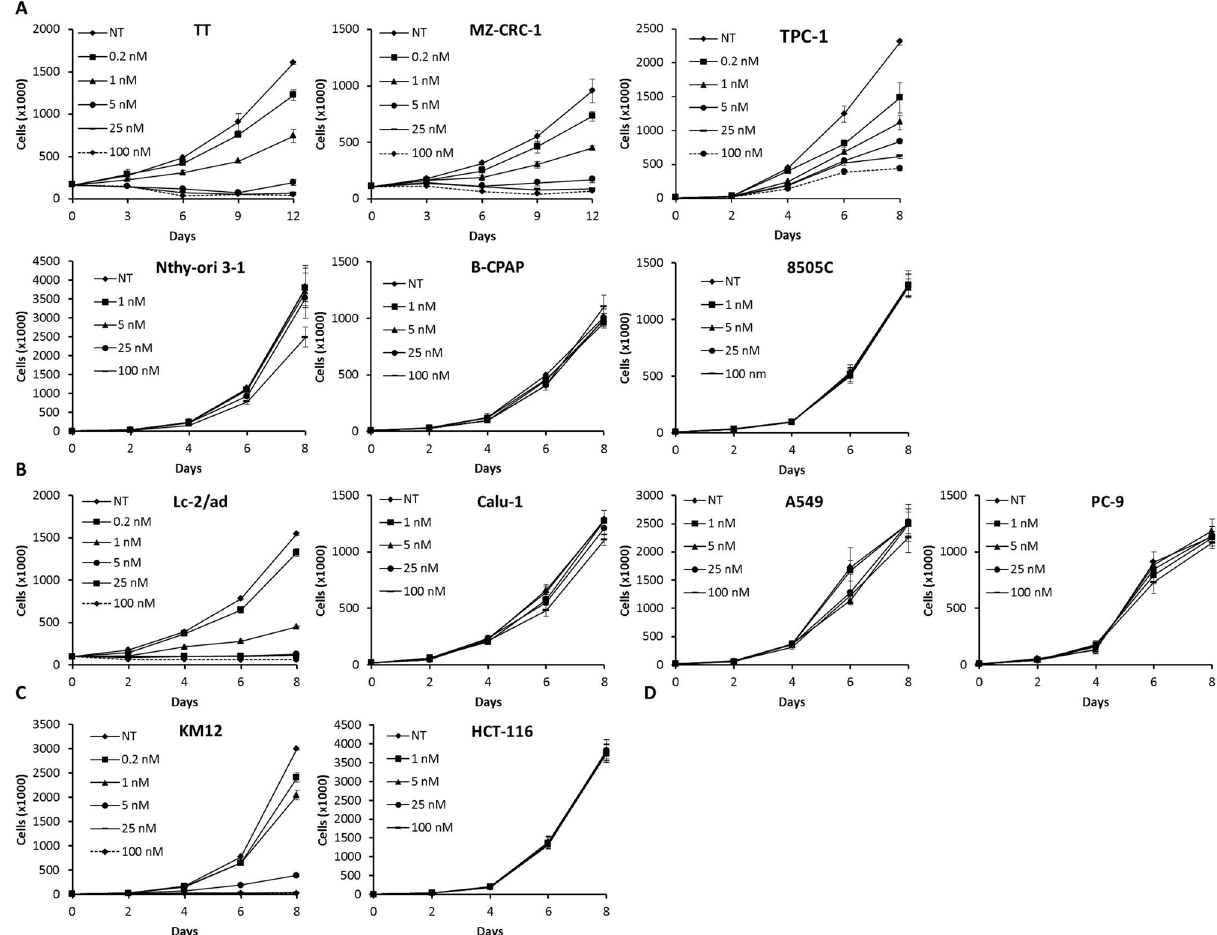
Figure 3. The indicated cell lines were incubated with vehicle (NT: not treated) or increasing concentrations of Pz-1 and counted at the indicated time points. Data are the mean ± SD of a single experiment performed in triplicate. Number of cells plated at Day 0: TT (200,000/well); MZ-CRC-1 and Lc-2/ad (100,000/well); Nthy- ori-3-1, 8505C, TPC-1 and HCT-116 (5,000/well); B-CPAP, A549, Calu-1, PC-9 and KM12